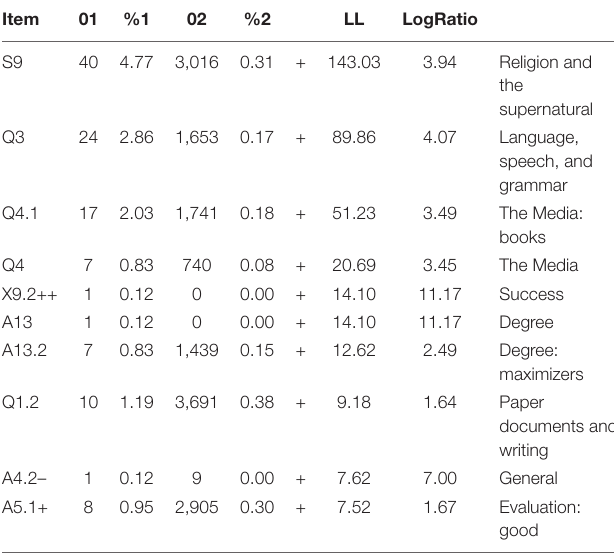
TABLE 5 | Key semantic domains for the text, Literature from the Bible